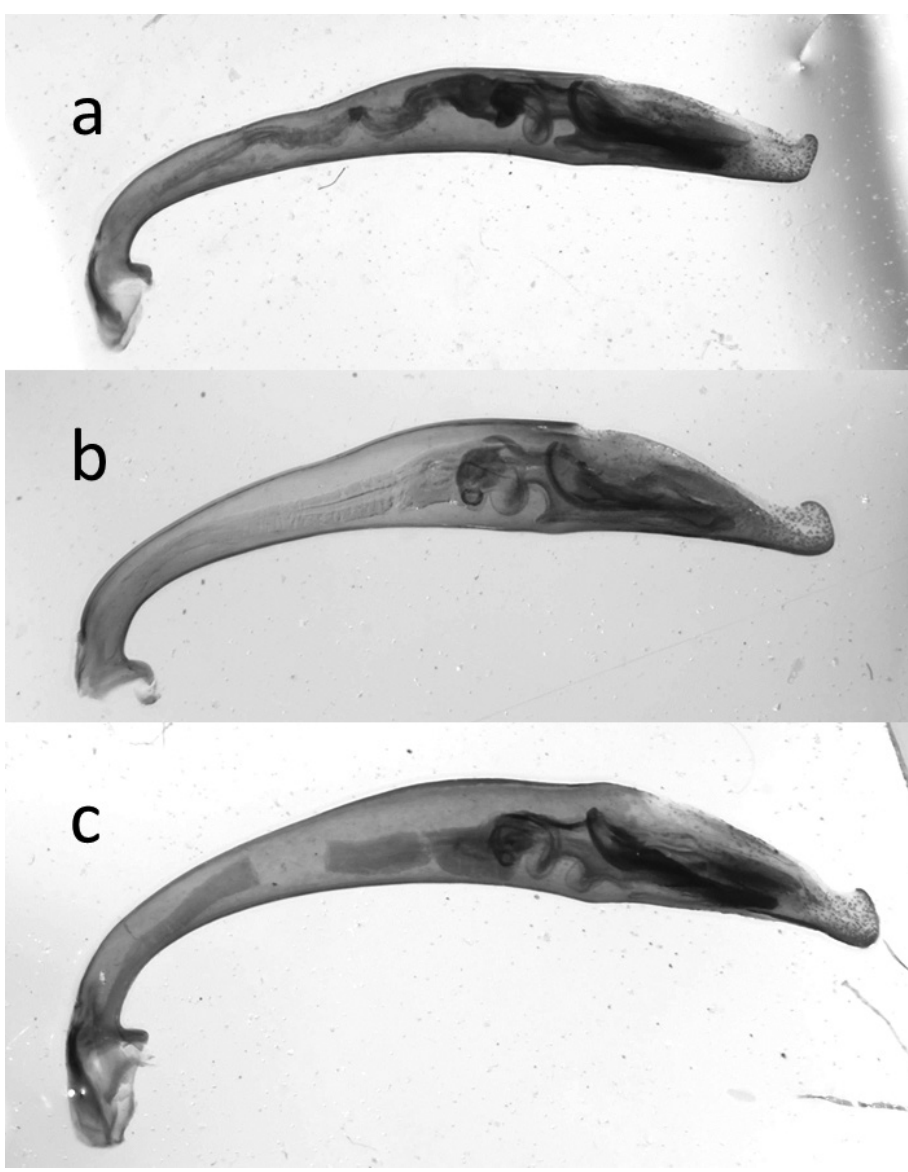
Figure 40. Median lobes of the aedeagus of species of the Calomera aulica group: a C. aulica b C. diania c C. aphrodisia .